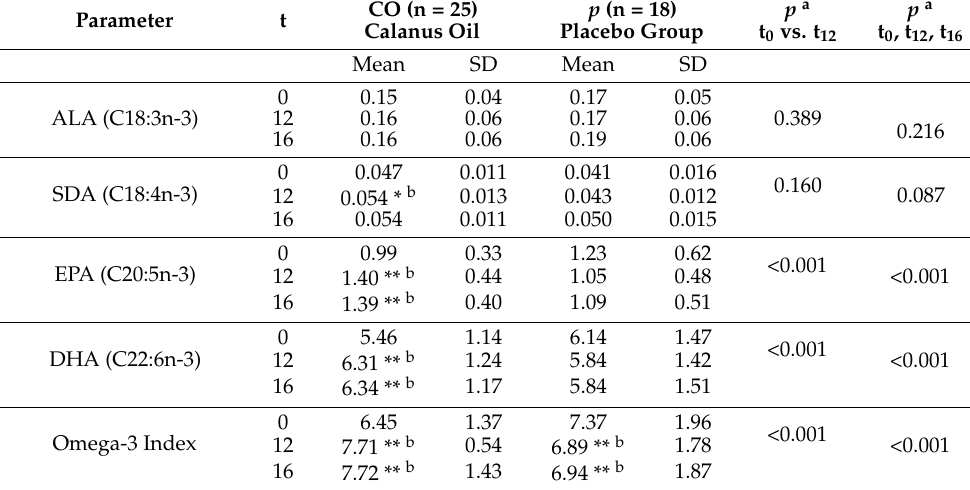
Table 4. Omega-3 Fatty acid content [%] of total fatty acids in in red blood cells (RBC) at the beginning (t 0 ), after 12 (t 12 ) and 16 (t 16 ) weeks of Calanus oil intervention. CO (n = 25) Parameter t Calanus